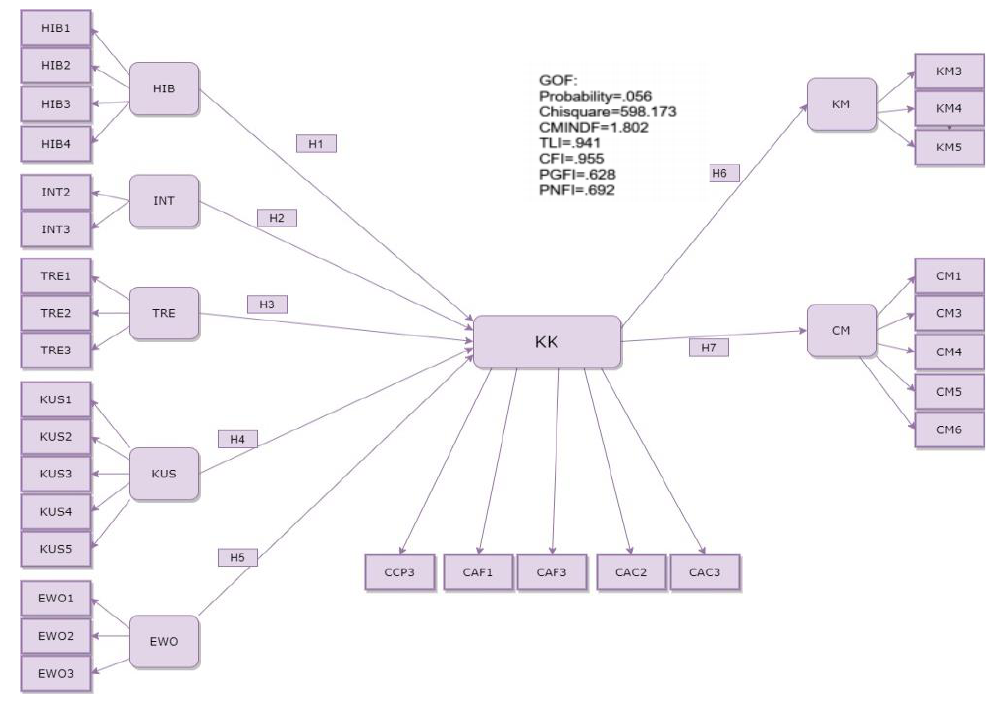
Figure 3: Hypothesis Analysis